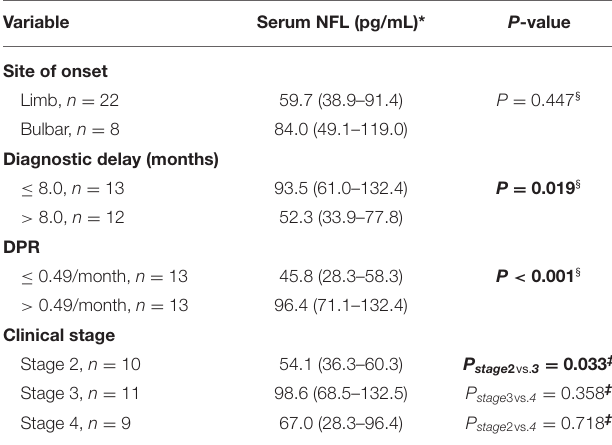
TABLE 2 | Serum NFL levels in the different subgroups of patients with ALS.